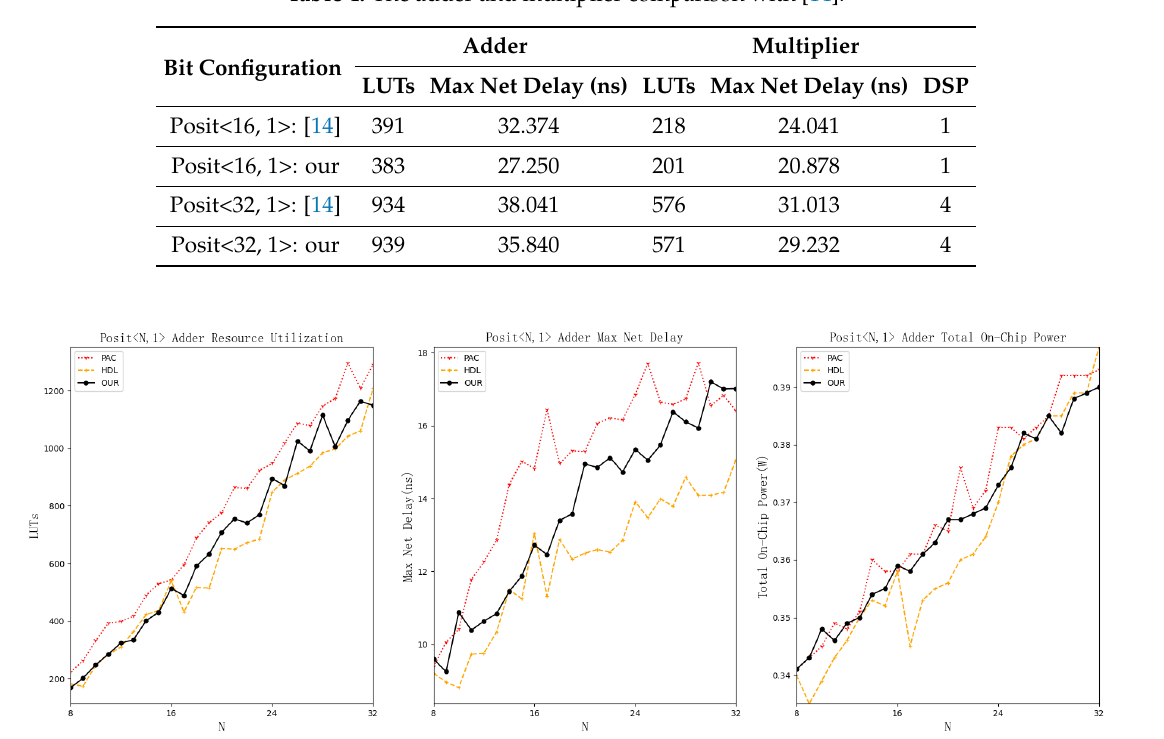
Table 4. The adder and multiplier comparison with [14].